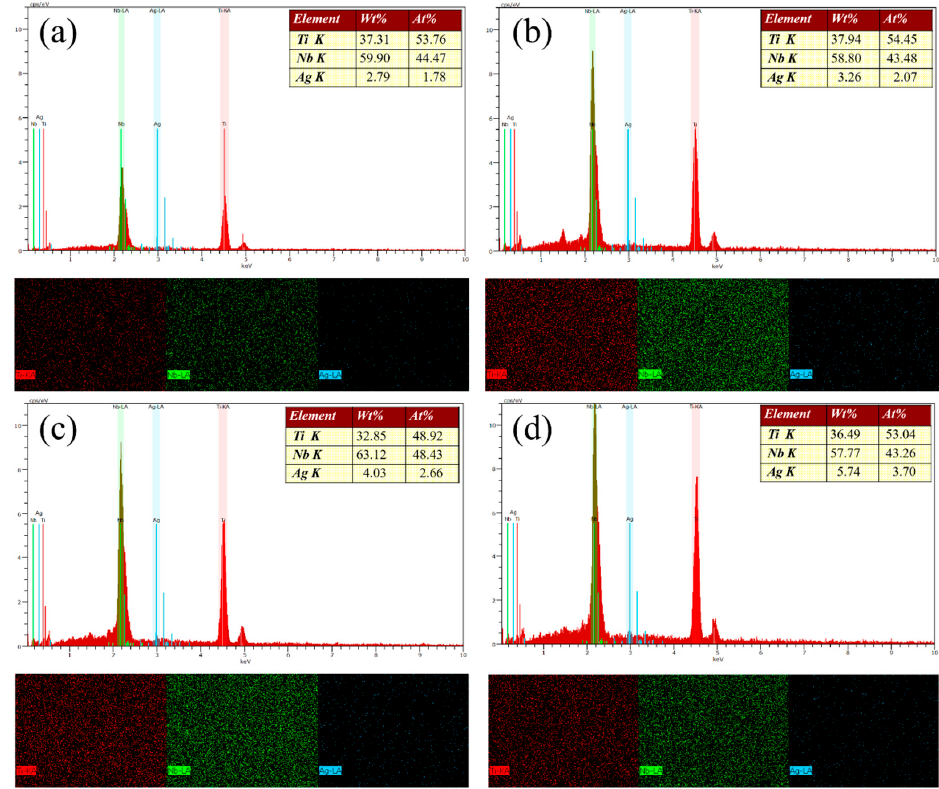
Figure 3. The surface element composition of TiNb alloy implanted by different doses of silver ions: ( a ) Ag-1 × 10 16 ions/cm 2 , ( b ) Ag-5 × 10 16 ions/cm 2 , ( c ) Ag-10 × 10 16 ions/cm 2 , and ( d ) Ag-15 × 10 16 ions/cm 2 .